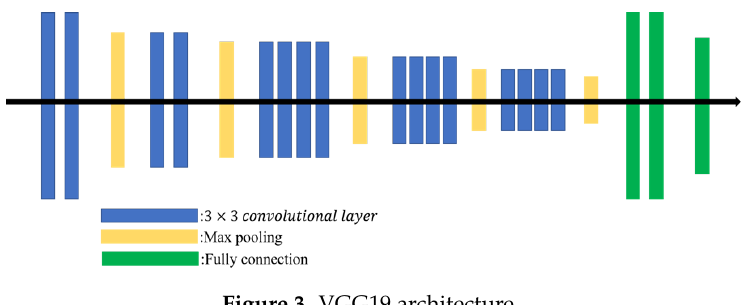
Figure 3. VGG19 architecture.